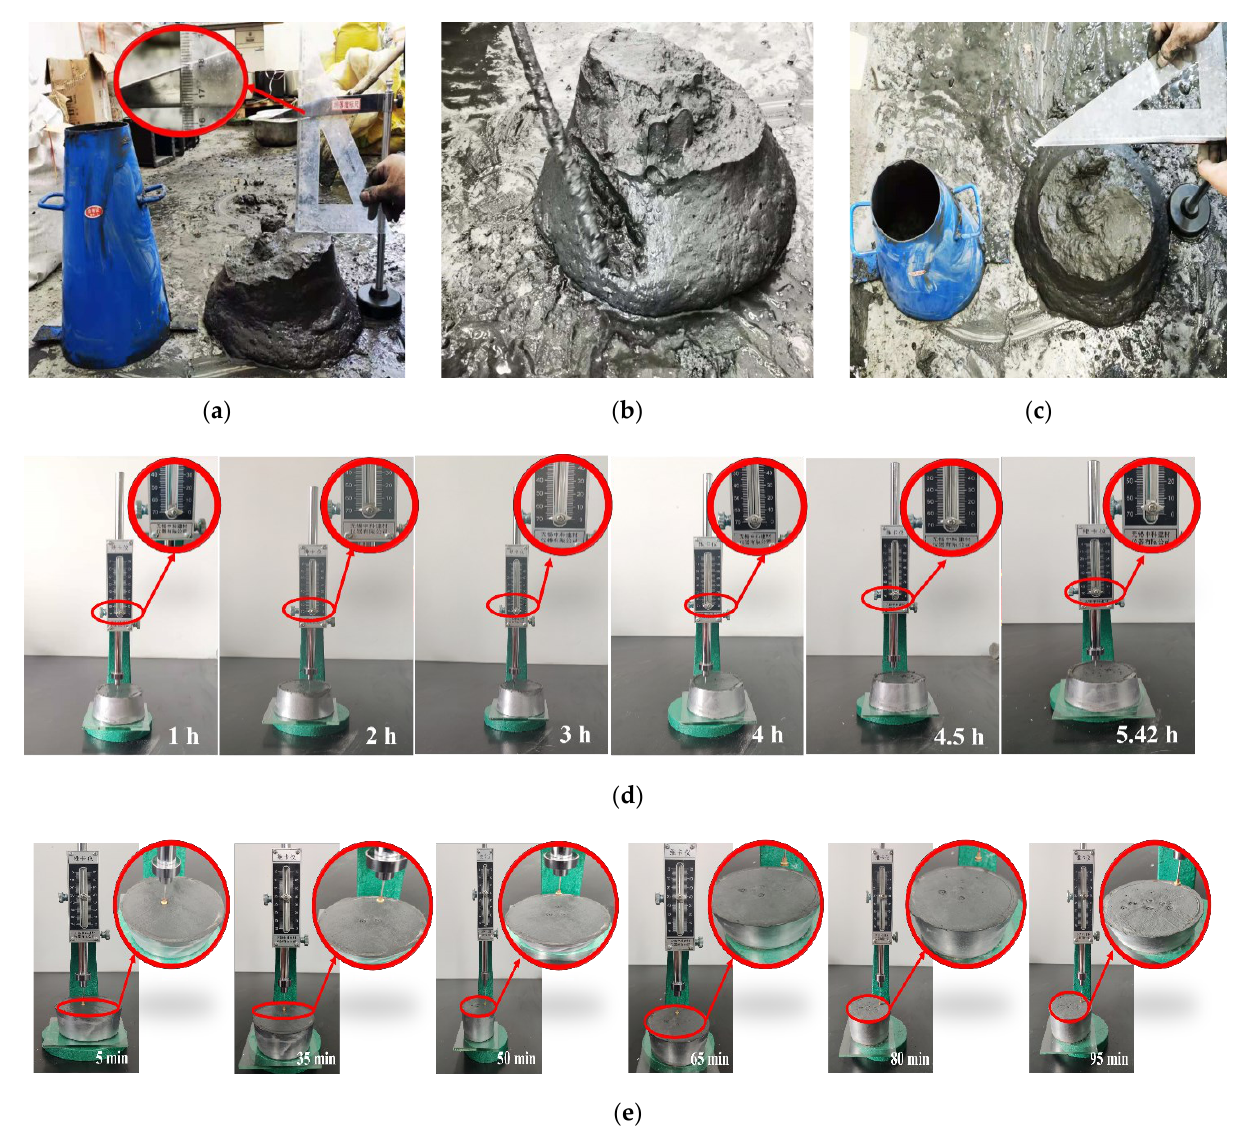
Figure 14. Engineering performance inspection of coal-based solid waste filling body. ( a ) Slump test; ( b ) cohesion test; ( c ) water retention test; ( d ) initial setting time test; ( e ) final setting time test.